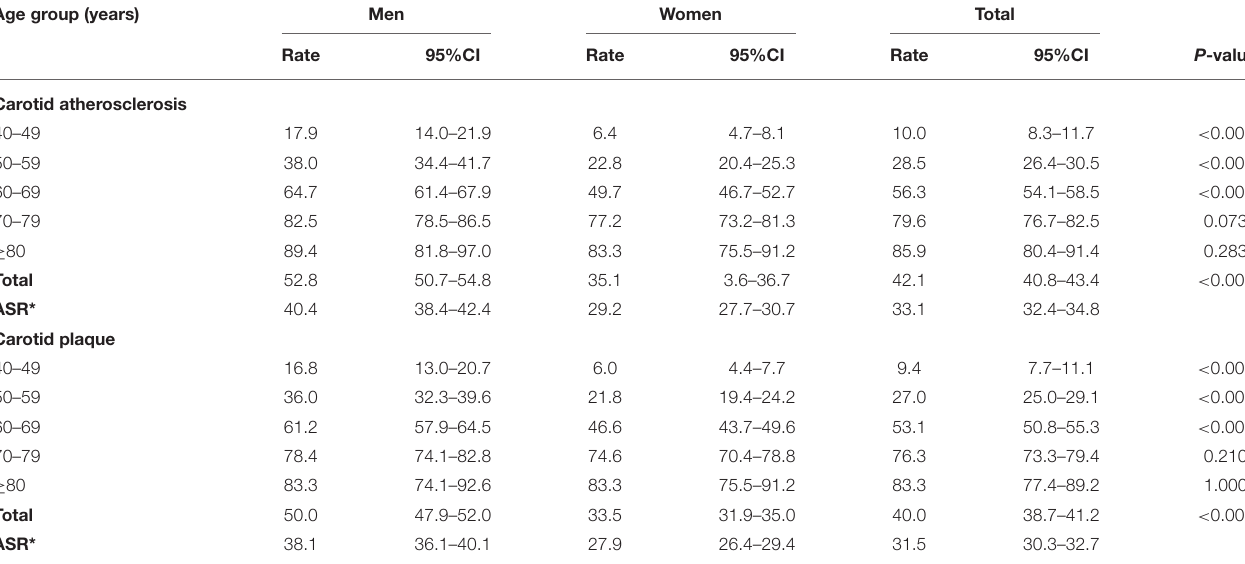
TABLE 2 | Prevalence of carotid atherosclerosis and carotid plaque among adults living in rural areas of Northeast China by sex in 2017–2018. Age group (years)